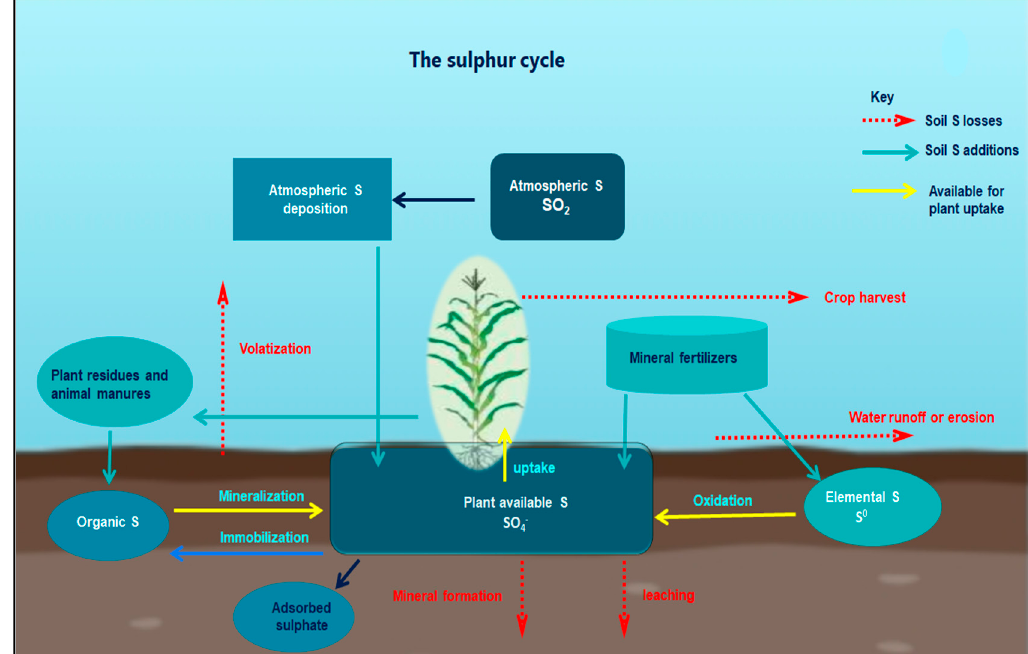
Figure 2. A simplified systematic representation of the sulphur (S) cycle (Adopted from https://www.nutrien-ekonomics.com accessed on 16 January 2021). Atmospheric S (SO 2 ) arises from burning S containing fossils, volcanic emissions and other natural processes. SO 42 − and sulphuric acid are deposited back on the earth through precipitation. Atmospheric deposition exists as dust settling on plants, emanating from mineral mining and rock erosion. Organic S becomes available when SOM is mineralized to SO 42 − . Addition of mineral S fertilizers ((NH 4 ) 2 SO 4 , CaSO 42 − , K 2 SO 4 , ZnSO 4 , MgSO 4 , S 0 , SSP, etc) to the soil improves the readily available soil S pool for plant uptake. The unharvested plant material and reused plant/agricultural residues return S back into the soil in an organic form. Animal manure and other biosolids also provide organic S into the soil, with the S quantity in such materials depending on the animal species, age and diet fed upon. Organic S must be mineralized to provide SO 42 − to the plants. Plant residual derived S becomes available only when residues are decomposed by soil microbes. S 0 needs biological oxidation, by means of several S oxidizing bacteria, to be transformed into plant available SO 42 − . Sulphur losses can be encountered through several processes. The loss of S through volatilization is quite small (< 0.05 percent of total soil S). SO 42 − may be leached out of the root zone due to excess rainfall or may accumulate at the soil surface in dry conditions. Under certain specific conditions, mineral formation processes may cause S to form relatively insoluble mineral complexes (CaSO 42 − , feSO 42 − , etc.). Surface losses of S can occur via runoff when SO 42 − is localized near the soil surface during high intensity rainfall events or via erosion when soil sediment is lost through erosion. The plant metabolic SO 42 − is harvested in seeds and other plants products. Detailed explanations to S cycle can be obtained from Till [34] and Eriksen et al. [51].